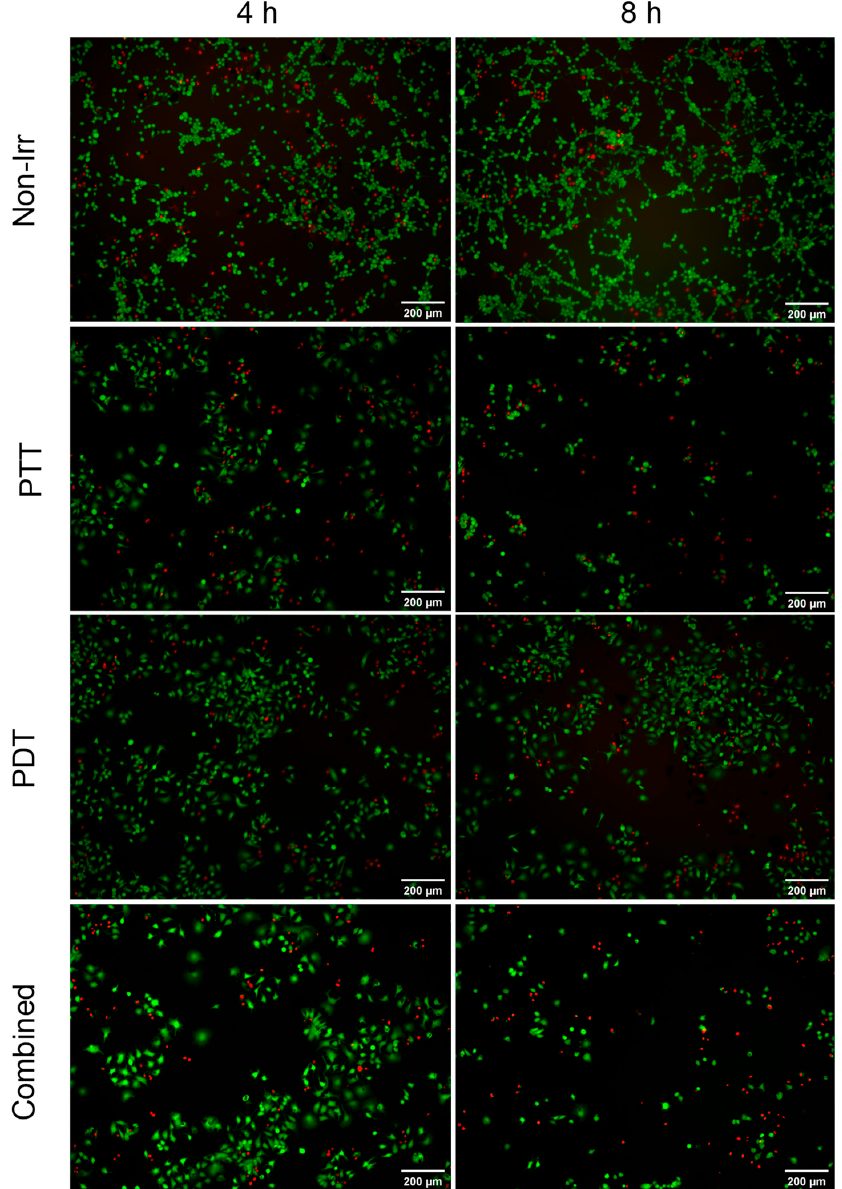
Figure 7. Fluorescence images of calcein AM (green signal from live cells, E x 495 nm and E m 517 nm) and EthD-1 (red signal from dead cells, E x 528 nm and E m 617 nm) double-stained cells after PTT, PDT and combined phototherapy treatments following the incubation with GO–FA/Ce6 for 4 and 8 h. MCF-7 cells incubated with GO–FA/Ce6 for 4 and 8 h without irradiation (Non-Irr) were used as control.